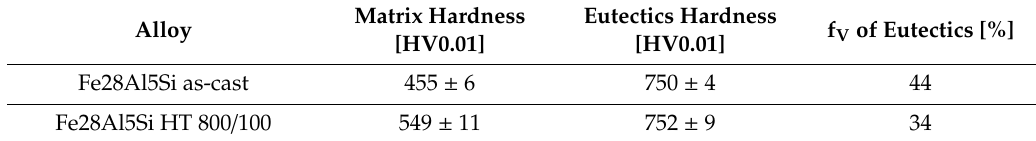
Table 2. Measured values of hardness and volume fraction of phases in both states of Fe28Al5Si alloy.